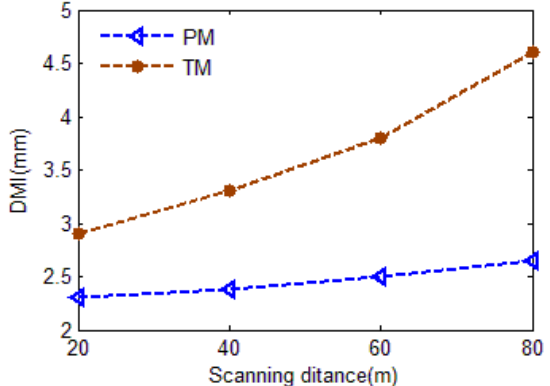
Figure 9. The DMI calculated by the PM and TM method respectively for each scanning